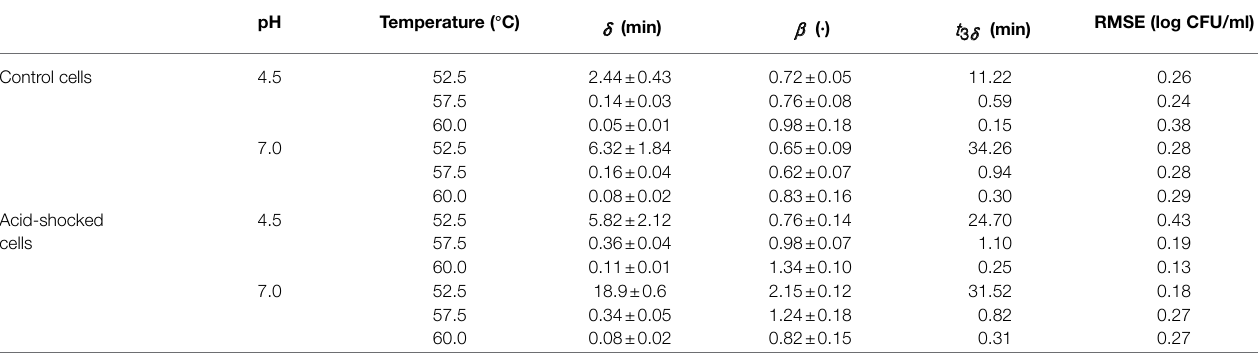
TABLE 2 | Parameters of the Weibull model estimated from the survival curves of S . Enteritidis heat treated in peptone water without a prior acid shock (control cells) and after an acid shock at pH